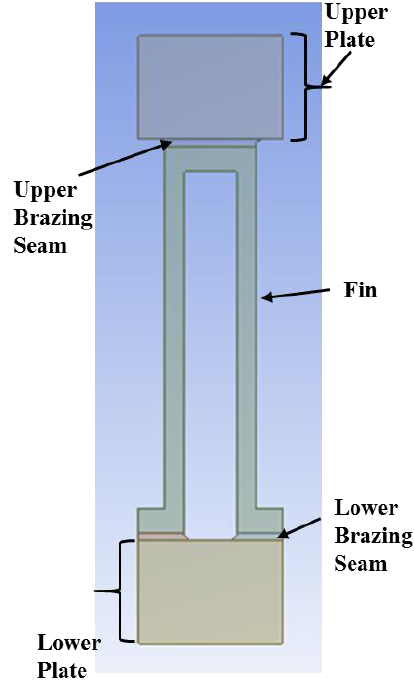
Figure 2. Main parts of single fin in plate-fin heat exchanger (PFHE).